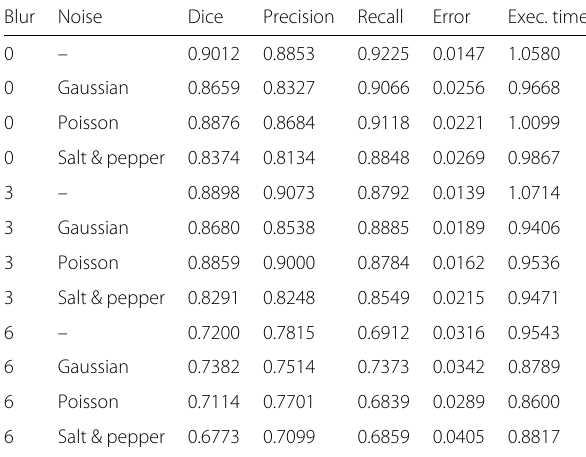
Table 8 Performance comparison with 15 degrees of rotation for each test carried out to assess the